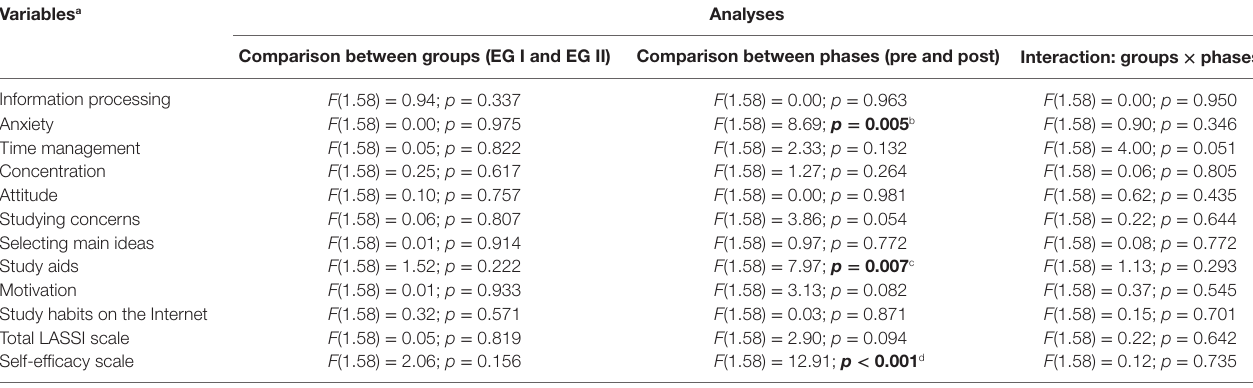
TaBle 2 | ANOVA results for comparison between the Experimental Group (EG) I—Class A and EG II—Class B scores. Variables a analyses comparison between groups (eg i and eg ii) comparison between phases (pre and post) interaction: groups × phases Information